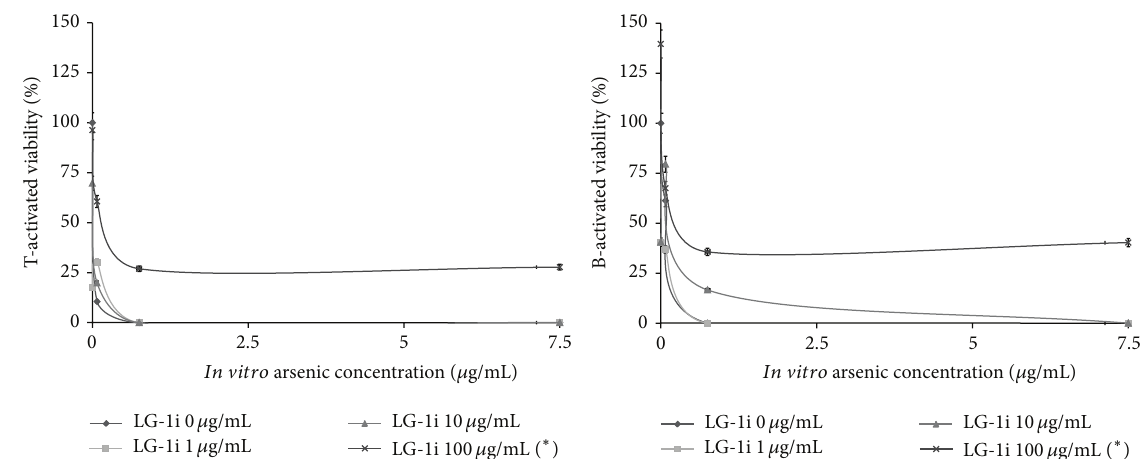
Figure 4: Viability of T- and B-activated cells treated for 72 h with 0–100 𝜇 g/mL of the 1h infusion L. grisebachii extract (LG-1i) and 0–7.5 𝜇 g/mL of arsenic. Percentages with respect to control (0 𝜇 g/mL LG-1i, 0 𝜇 g/mL As) were average from four separate experiments ( ∗ 𝑃 < 0.0001 ).